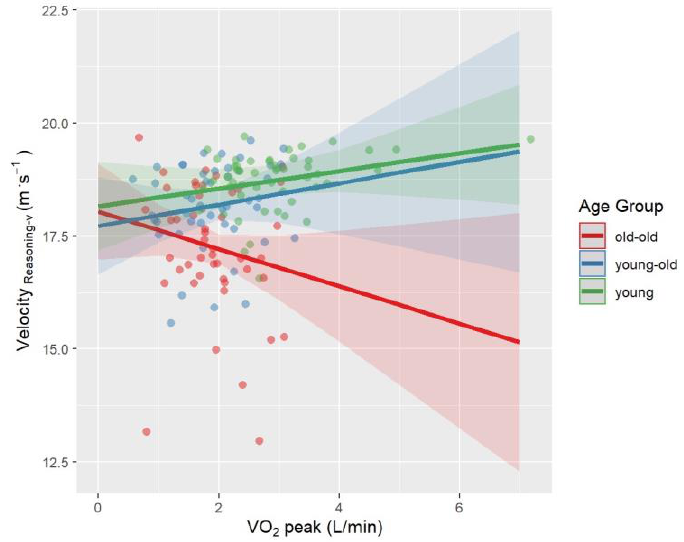
Figure 4. Interaction effect between age and VO 2 peak on Velocity Reasoning-v after controlling for BMI and sex. The fit lines represent the trend of the data for subgroups. Green: young adults, Blue: young-old adults, Red: old-old adults. Young and young-old adults with higher VO 2 peak drove faster, while old-old adults drove slower.